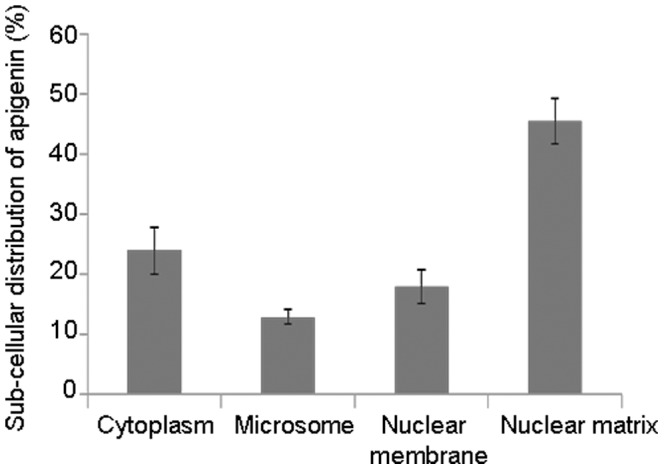
Sub-cellular distribution of apigenin in human prostate cancer LNCaP cells.The cells were incubated with 20 µM apigenin for 48 h with approximately 5×106 cells and processed for different fractions. Bars±SD of experiments performed three times. Distribution is represented as 100% apigenin in all the fractions. Details are described in materials and methods section.